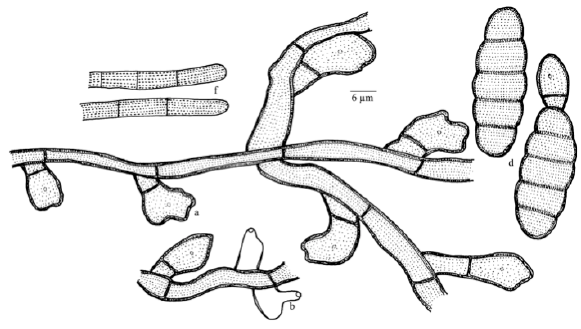
Figure 28. Irenopsis molleriana a - Appressorium; b - Phialide; f - Apical portion of the perithecial setae; d - Ascospores